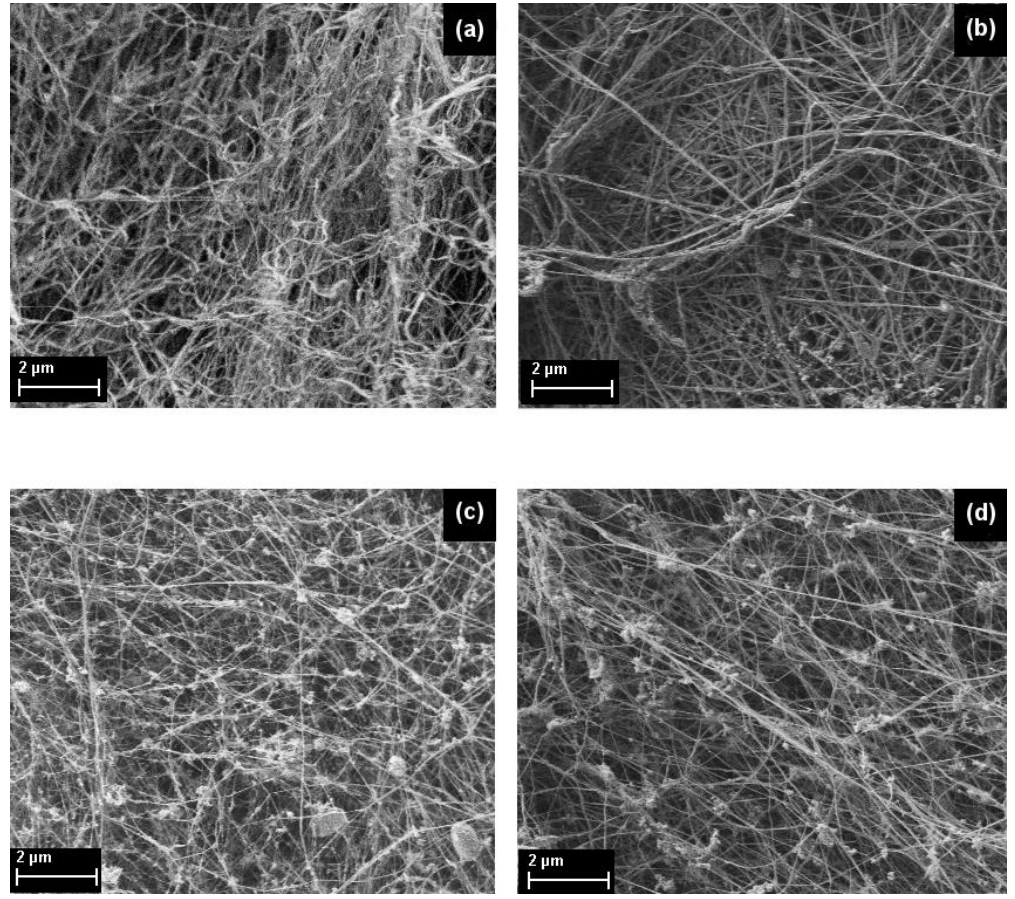
Figure 8. Variation of SEM topologies of the supercritically dried samples of BC: native nano-gel film ( a ) and treated by CBHSc for 120 ( b ), 240 min ( c ), and 24 h ( d ), respectively.